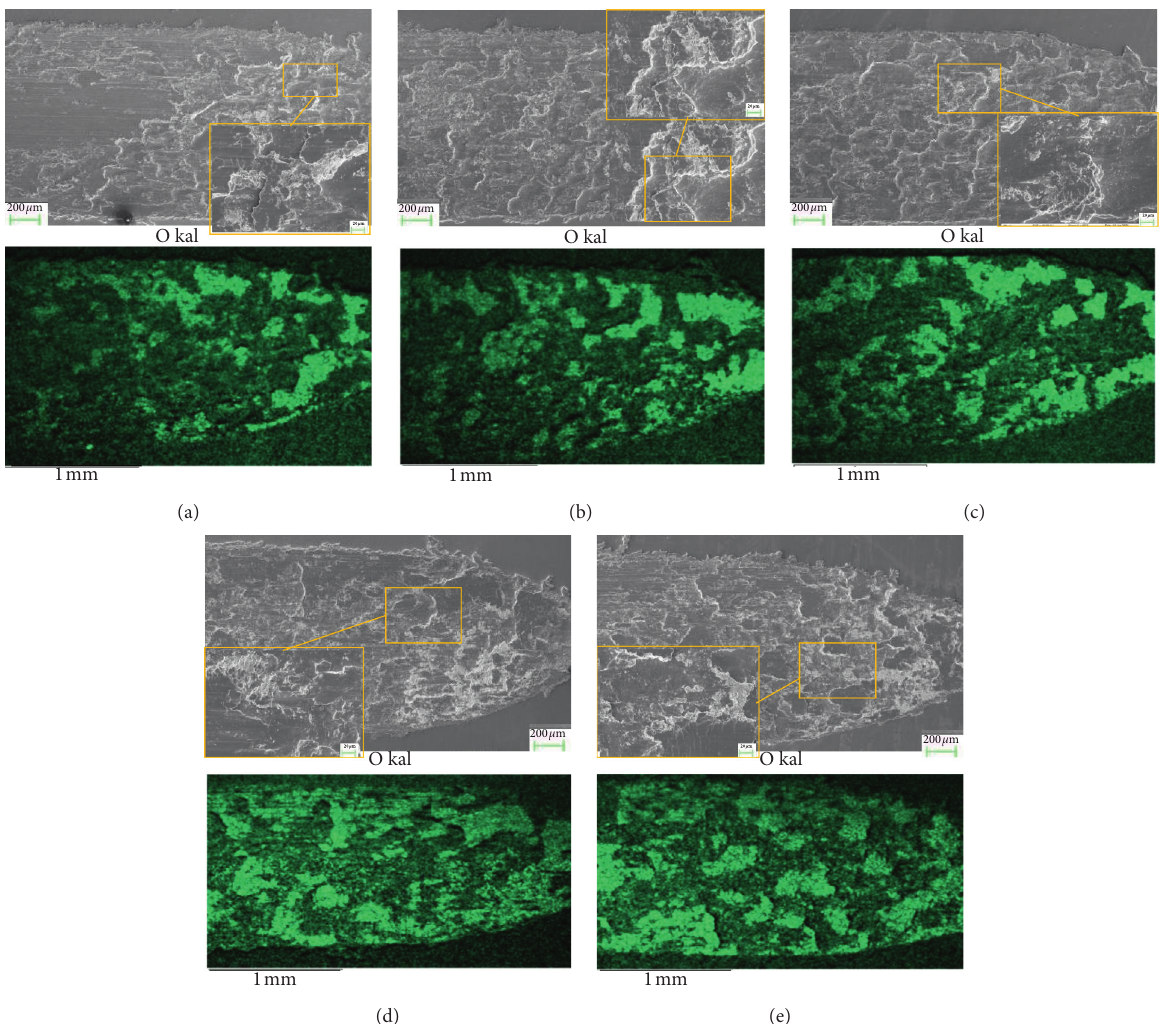
Figure 6: Wear morphology (from middle to edge) and surface oxygen energy spectrum distribution of dual-phase steel at different solution temperatures under dry friction